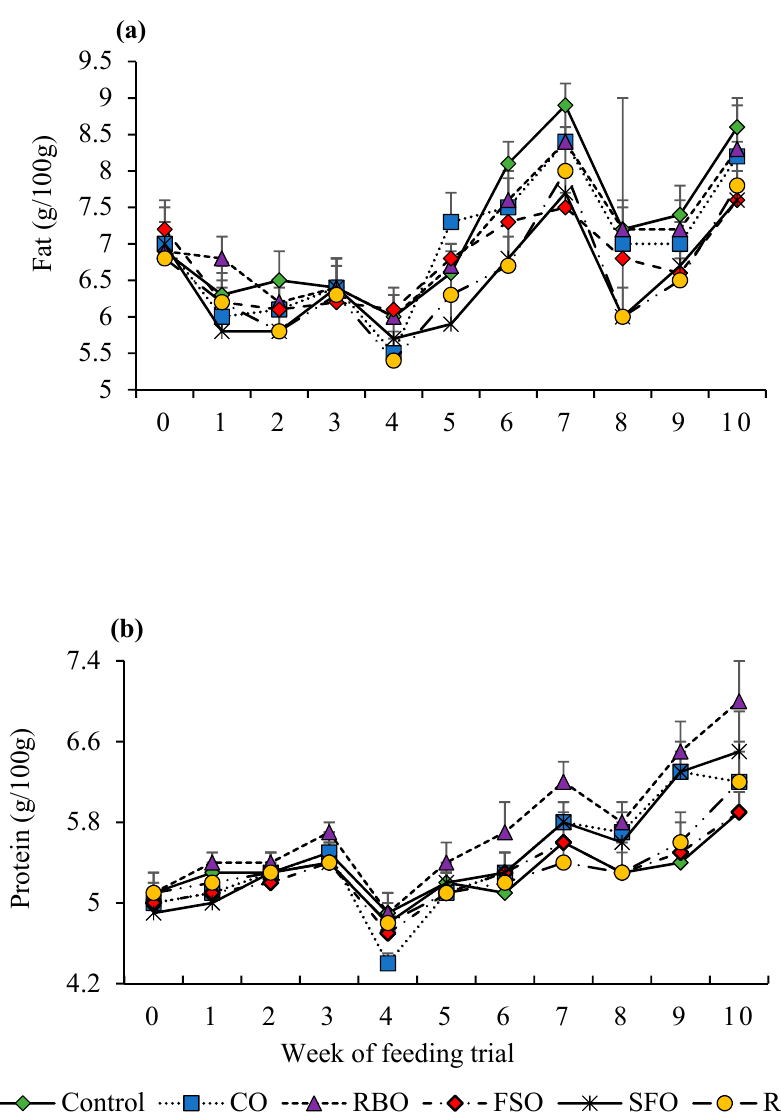
Figure 2. Weekly trends in milk fat ( a ) and milk protein ( b ) concentration. Canola oil (CO), rice bran oil (RBO), flaxseed oil (FSO), safflower oil (SFO), rumen-protected oil (RPO).